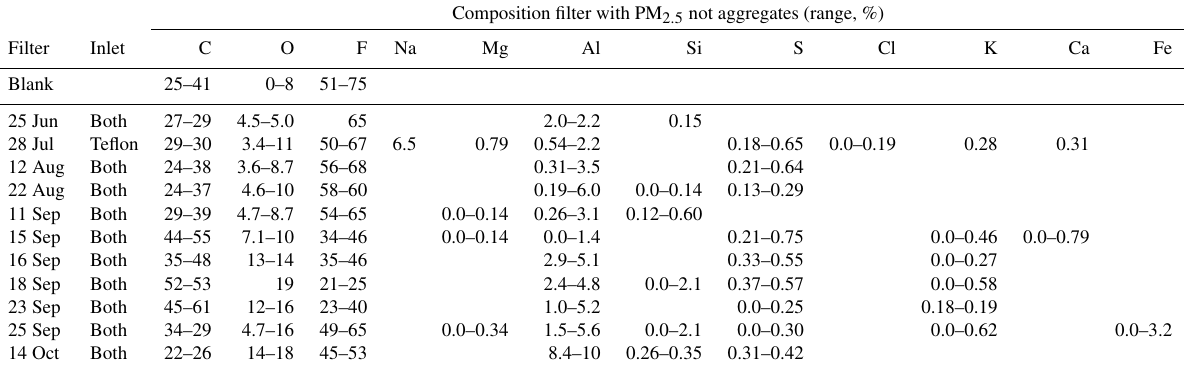
Figure 11. Teflon filters from (a) 21 October 2014 during multiple generators running at PEAV and (b) 25 October 2014 the day after multiple generators were running at PEAV. Table 2. Days at PEAV in 2014 with visible aggregates on filters, the inlet with aggregates (CEM – cation exchange membranes, Teflon filters, or both inlets), and the elemental composition of sections of Teflon with particulate matter, but no aggregates. Composition filter with PM 2 . 5 not aggregates (range,